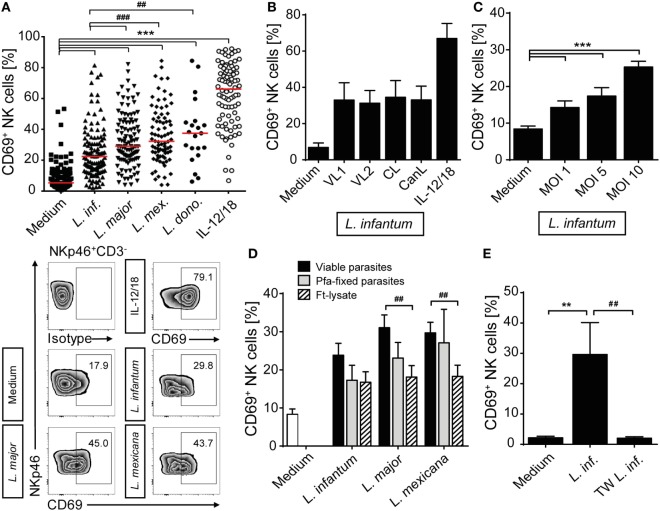
CD69 is upregulated on natural killer (NK) cells after contact with Leishmania. Human peripheral blood mononuclear cells were cocultured for 20 h with Leishmania promastigotes of different species (A), strains (B), amounts (C), or integrity (D), and with or without host cell/parasite contact (E) or interleukin (IL)-12 and IL-18 (10 ng/ml) (A,B), followed by surface expression analysis of CD69 on NKp46+CD3− NK cells by flow cytometry. Unless otherwise indicated the multiplicity of infection (MOI) was 10. (A) Results of 129/117/107/83/21/88 blood samples for the six stimulations. Medians are indicated by red lines. FACS plots show results of NKp46+CD3− NK cells of one representative experiment. (B)
Leishmania infantum strains isolated from human patients with visceral leishmaniasis (VL) (VL1, VL2) or CL or a dog [canine leishmaniasis (CanL)]. Mean ± SEM of 9/9/9/9/7/9 donors. (C) Mean ± SEM of 119/43/17/119 donors for the four stimulations. (D) Mean ± SEM of 22/22/18/18 (viable), 8/9/6 [paraformaldehyde (Pfa)-fixed], and 17/15/14 [freeze–thaw lysate (Ft-lysate)] donors. (E) Mean ± SEM of six donors. Abbreviation: TW, transwell. *,#p < 0.05; **,##p < 0.01; and ***,###p < 0.001 two-tailed Mann–Whitney U test.